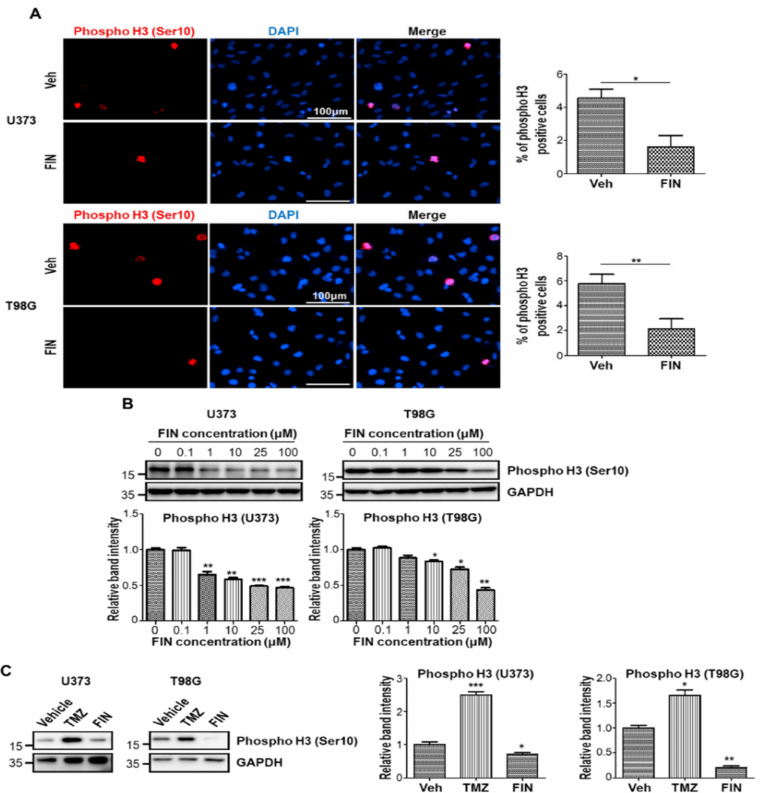
Figure 2. High-dose finasteride suppresses the proliferating capacity of glioblastoma cells. ( A ) U373 (upper) and T98G (lower) cells were treated with vehicle or 100 µ M finasteride (FIN) for 24 h, and they were immunostained with a phospho histone 3 (Ser 10)-specific antibody (red). Nuclear DAPI (4 (cid:48) , 6-diamidino-2-phenylindole) signal is presented in blue (left). The quantification of phospho histone 3-positive cell proportions in vehicle- or FIN-treated cells (right). ( B ) Immunoblot analysis of phospho histone 3 in U373 (left) or T98G (right) cells after treatment with vehicle or FIN at the indicated concentration for 24 h. GAPDH was used as a loading control. The relative band intensities of phospho histone 3 are shown below. The intensities of vehicle-treated samples were arbitrarily set to 1. ( C ) Immunoblot analysis of phospho histone 3 in U373 (left) or T98G (right) cells upon treatment of DMSO or temozolomide (TMZ) or 100 µ M FIN for 24 h. GAPDH was used as a loading control. The relative band intensities of phospho histone 3 are represented. The intensities of vehicle-treated samples were arbitrarily set to 1. * p < 0.05, ** p < 0.01, *** p <